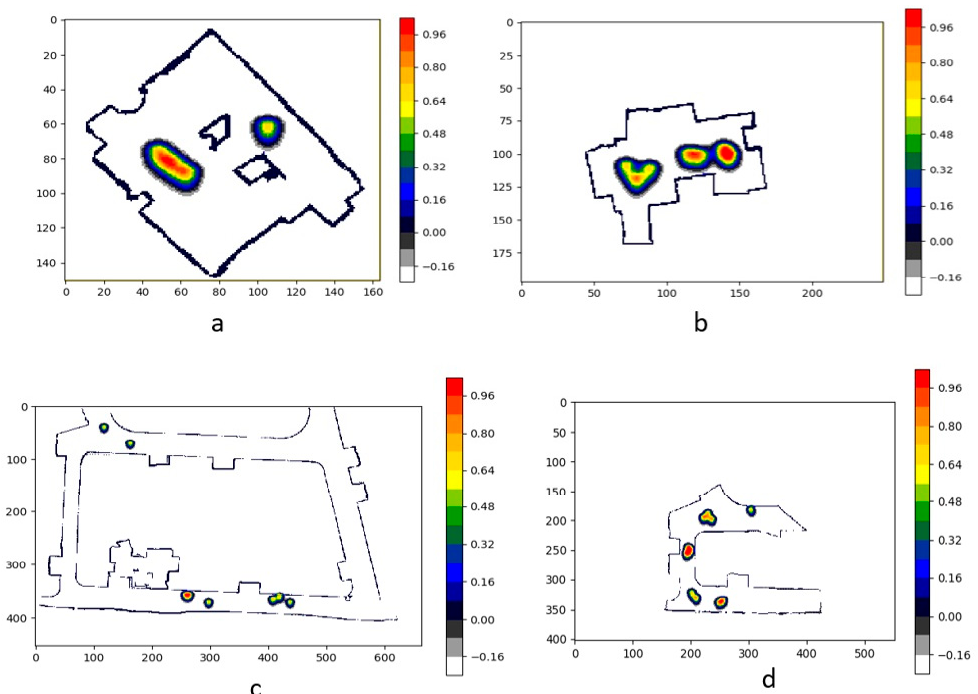
Figure 10. Heat map distribution plotted on the grid maps for scenarios I to IV based on the human interactions.